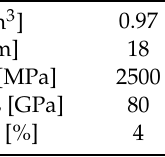
Table 2. Physical and mechanical properties of HDPE